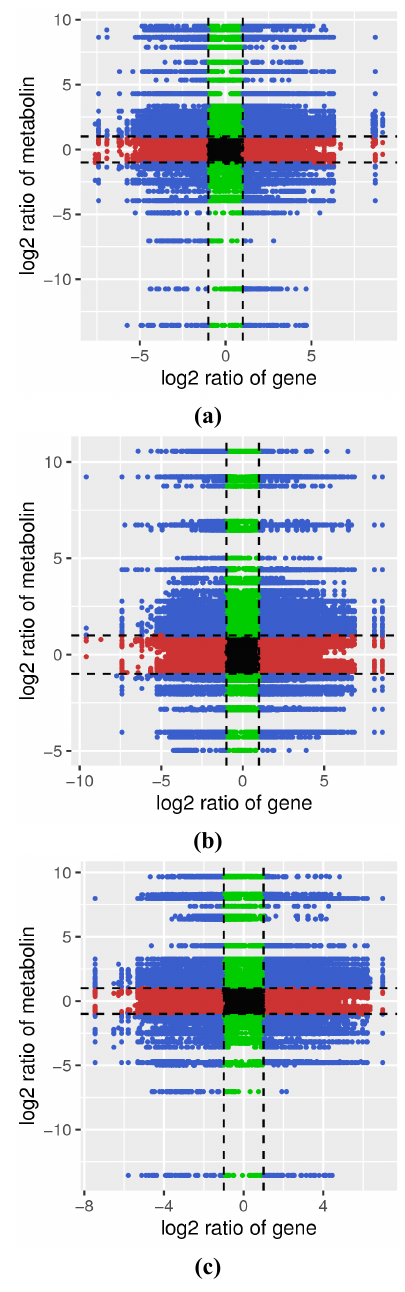
Figure 6. Quadrant diagrams representing the association of metabolomic and transcriptomic data. ( a ) Overview of metabolomic and transcriptomic variation in WT vs. a-3. ( b ) Overview of metabolomic and transcriptomic variation in WT vs. a-4. ( c ) Overview of metabolomic and transcriptomic variation in WT vs. a-5. The abscissa represents the fold changes in the transcriptome data, and the ordinate represents the fold changes in the metabolome data. The black dotted lines represent the di ff erential thresholds. Each point represents a gene / metabolite. Blue dots represent that genes and metabolites were both changed; black dots represent unchanged genes / metabolites; green dots represent DAMs with unchanged genes; red dots represent di ff erentially expressed genes (DEGs) with unchanged